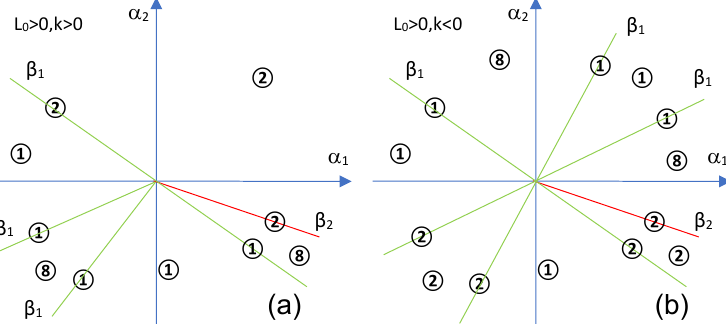
Figure 1. Bifurcation diagrams when p < 0, r < 0, and hk > 0: ( a ) L 0 > 0, k > 0; ( b ) L 0 > 0, k < 0.